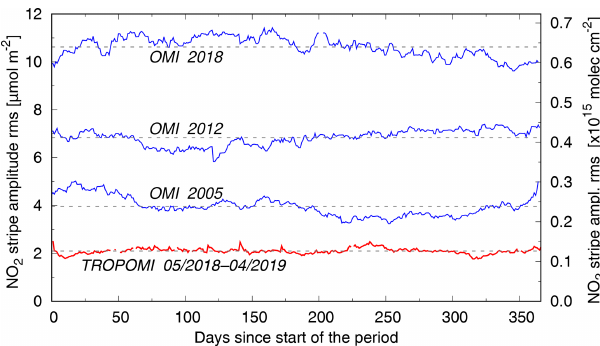
Figure 5. Comparison of the time evolution of the rms of the NO 2 SCD stripe amplitude over the first year of TROPOMI data (red; cf. Fig. 4c) and over selected OMI–QA4ECV years (blue); the main increases in the OMI rms occur during 2006, 2010–2011 and 2014– 2015. Dashed lines indicate averages over the year periods.